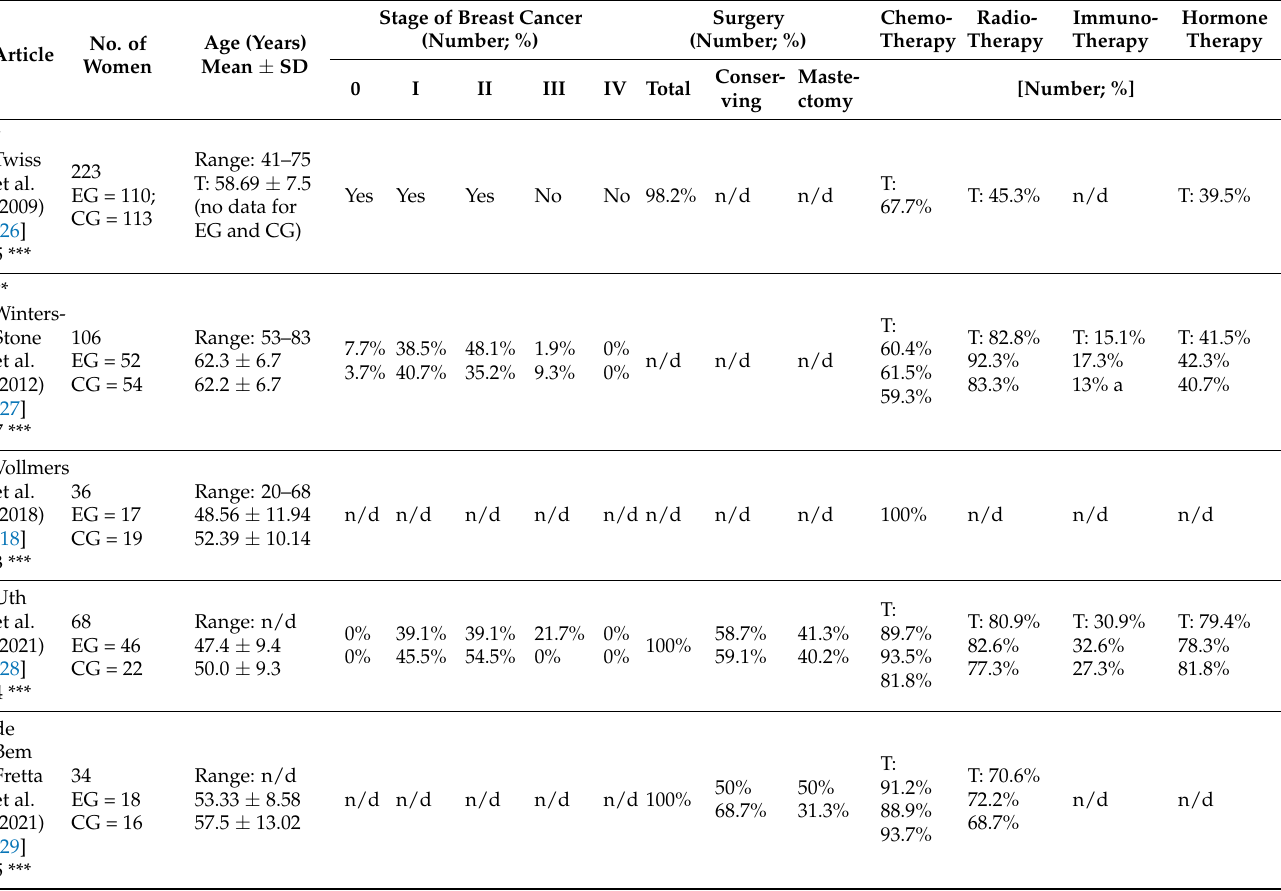
Table 4. Characteristics of the groups in randomized clinical